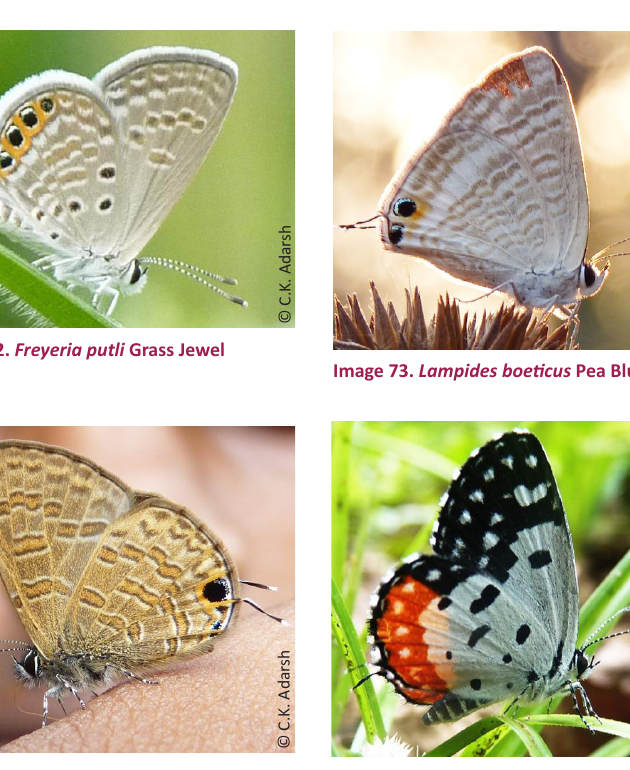
Image 75. Prosotas nora Common Line-blue